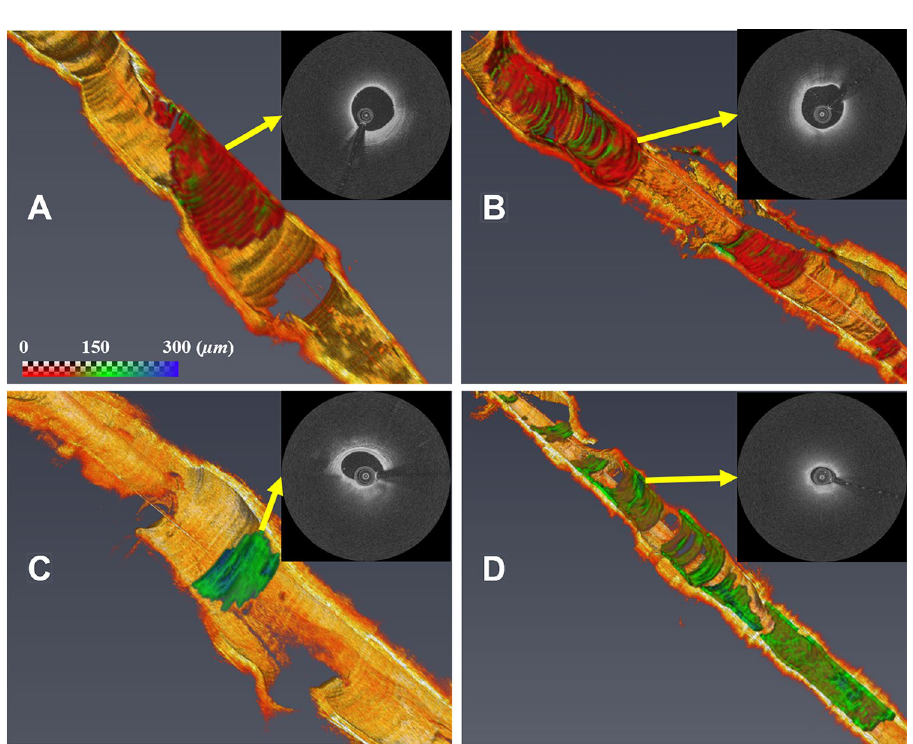
Figure 9. Three-dimensional (3D) visualizations of fibrous cap thickness on the representative IVOCT pullbacks, including: ( A ) short lesion with TCFA, ( B ) long lesion with TCFA, ( C ) short lesion without TCFA, and ( D ) long lesion without TCFA. The reader can zoom in each artery to see variations of fibrous cap thickness. ( A ) Although the lesion length was not too long (< 7 mm), the average fibrous cap thickness was less than 65 µm across the lesion indicating that the lesion is prone to rupture. ( B ) There were two lipidous lesions having 15 mm (left) and 5 mm (right) lengths. Both lesions were heavily lipidic with a mean cap thickness of < 65 µm. The artery was much more prone to rupture than ( A ). ( C ) The lesion was stable, since the length was short (< 3 mm) and the fibrous cap thickness was always greater than 150 µm. ( D ) Although the fibrous cap thickness was always over 80 µm across the lesion, the lesion length was very long (> 30 mm). There were several spots approaching toward the vulnerable plaque than ( C ). The color map visualizes the fibrous cap in the range of 0 to 300 µm. The yellow arrows indicate representative IVOCT frames of each rendering. Our method provides comprehensive fibrous cap map in the entire IVOCT pullback, so clinicians can make appropriate treatment